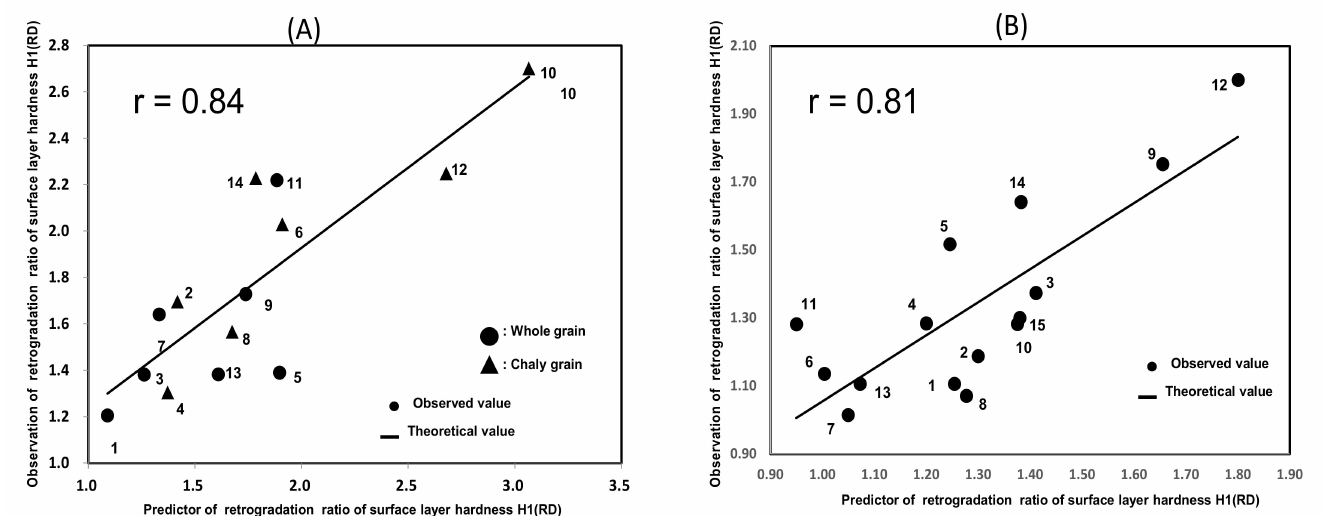
Figure 4. The estimation formula for the H1 (RD) of cooked rice grains based on the pasting properties using RVA and α - amylase activities; ( A ) Estimation formula: The following formula for estimating the H1(RD) was obtained using whole rice grains from 7 Japonica rice samples and those chalky rice grains. (1, Morinokumasan (whole grains); 2, Morinokumasan (chalky grains); 3, Koshihikari (Shibata) (whole grains); 4, Koshihikari (Shibata) (chalky grains); 5, Koshihikari (Tochio) (whole grains); 6, Koshihikari (Tochio) (chalky grains); 7, Koshihikari (Toukamachi) (whole grains); 8, Koshi- hikari (Toukamachi) (chalky grains); 9, Hanaechizen (whole grains); 10, Hanaechizen (chalky grains); 11, Koshihikari (Oguni) (whole grains); 12, Koshihikari (Oguni) (chalky grains); 13, Sasanishiki (whole grains); 14, Sasanishiki (chalky grains); ( B ) Examination estimation formula with unknown samples: The formula for validation test using 15 unknown samples (1, Tsuyahime (Shimane); 2, Sagabiy- ori (Saga); 3, Oidemai (Kagawa); 4, Hatsushimo (Gifu); 5, Akihonami (Kagoshima); 6, Nikomaru (Kouchi);7, Hitomebore (Miyagi); 8, Yukiwakamaru (Yamagata); 9, Akitakomachi (Akita); 10, Seiten- nohekireki (Aomori); 11, Koshihikari (Hyogo); 12, Koshihikari (Nagano); 13, Tsuyahime (Yamagata); 14, Koshihikari (Niigata; Muikamachi); 15, Koshihikari (Niigata; Sado); H1(RD); retrogradation